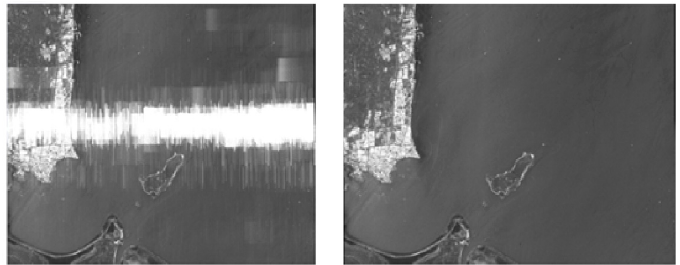
Figure 1. RFI in ENVISAT image before removal ( left ) and after removal ( right ) (data are courtesy of European Space Agency (ESA)).